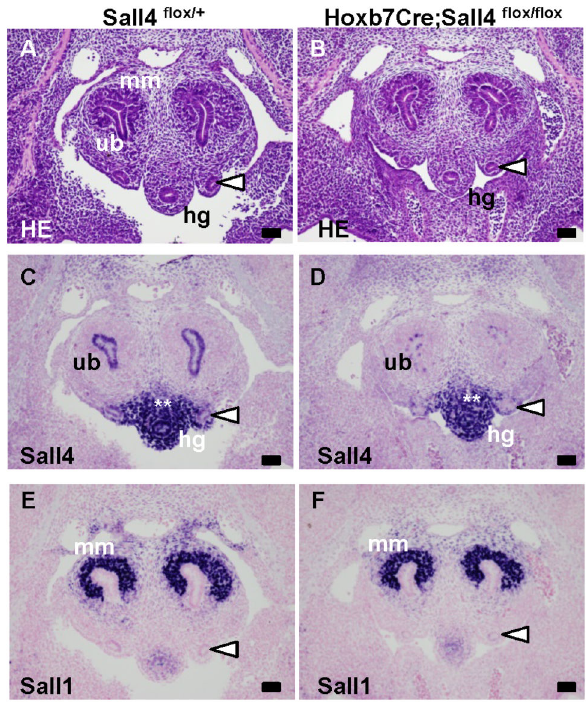
Figure 4. Sall4 is deleted in the ureteric bud and Wolffian duct in Hoxb7Cre; Sall4 flox/flox mice. (A, B) Hematoxylin and eosin staining of control and Sall4 mutant kidneys at E11.5. (C, D) Sall4 staining of the neighboring sections. (E, F) Sall1 staining of the neighboring sections. White arrowhead: caudal end of the Wolffian duct; white double asterisk: tissues surrounding kidney primordia and hindgut; hg: hindgut; mm: metanephric mesenchyme; ub: ureteric bud. Scale bars: 50 µm.